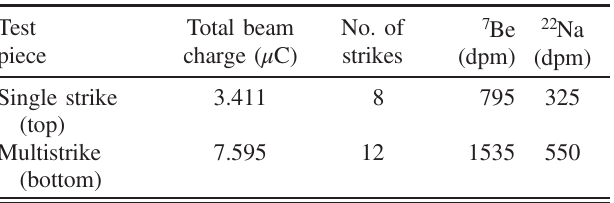
TABLE VII. Induced activity of the January 2020 collimator test pieces.